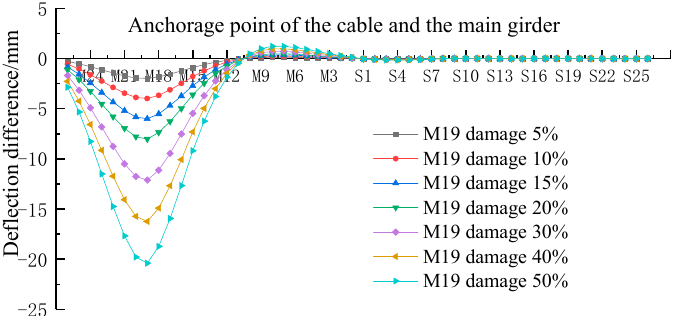
Figure 8. The distribution curves of the deflection difference of the girder before and after different degrees of damage of the stay cable M19.